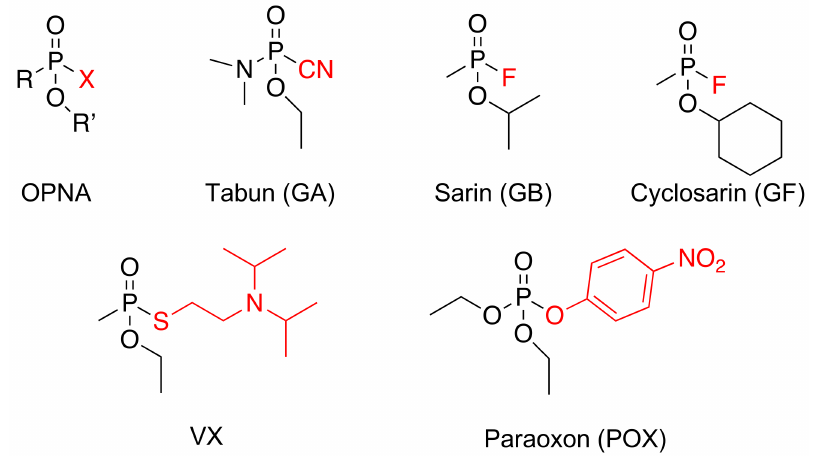
Figure 1. Global chemical structure of organophosphorus nerve agents (OPNA) and specific toxics or pesticides used in the present study. In red is represented the leaving group that is lost upon phosphylation of the